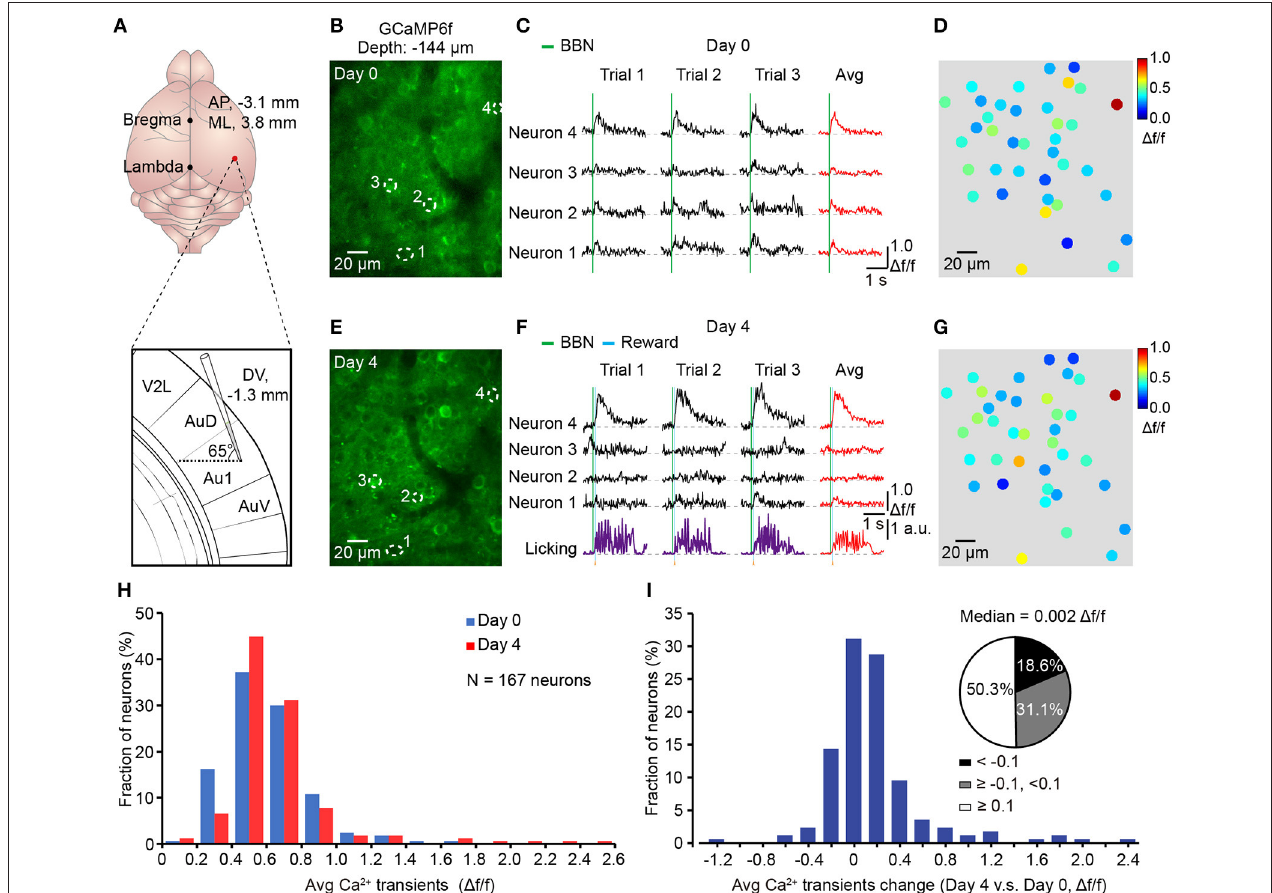
FIGURE 7 | Chronic Ca 2 + imaging in the Au1 throughout associative learning . (A) Upper, precise location of opening for virus injection. Lower, expanded view of titling electrode. (B) Average image (400 frames) of a focal plane in layer 2/3 of the Au1 before training (Day 0). (C) Sound-evoked Ca 2 + transients from the neurons outlined with dashed circles in B . Three consecutive trials and their average in each neuron are shown. (D) Color mapping of the average amplitude of three consecutive trials evoked by the BBN for each neuron in B before training (Day 0). (E) Average image (400 frames) of the same focal plane after training (Day 4). (F) Sound-evoked Ca 2 + transients from the same neurons after training. The simultaneous licking behaviors are also presented. (G) Color mapping of the average amplitude of three consecutive trials evoked by the BBN for each neuron after training (Day 4). (H) Distribution of the averaged response amplitudes of 3 consecutive trials in naive (Day 0) and conditioned (Day 4) states, respectively. N = 167 neurons from 4 mice. (I) Histogram shows the distribution of the change (Day 4 vs. Day 0) in the averaged Ca 2 + amplitude of each neuron. Pie chat shows 50.3% neurons changed ≥ 0.1 1 f/f (White), 18.6% neurons changed < -0.1 1 f/f (Black) and the others between